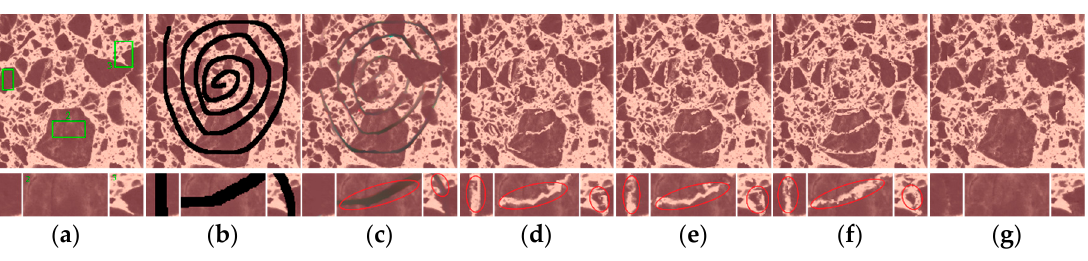
Figure 10. Comparison of inpainting results for irregular pattern Texture I (640 × 640): ( a ) Ground truth; ( b ) incomplete image; ( c ) CDD model [4]; ( d ) Criminisi’s method [10]; ( e ) Liu’s method [17]; ( f ) Zhou’s method [18]; ( g ) proposed